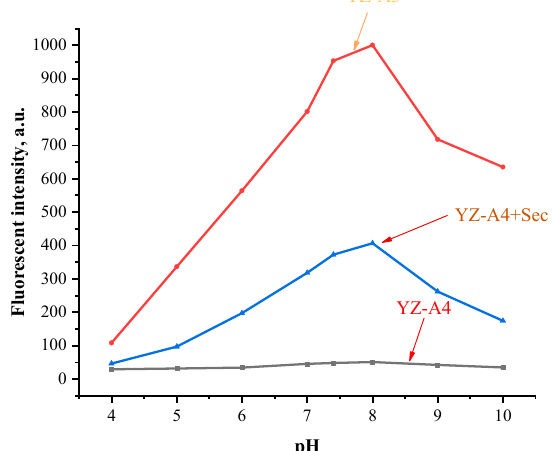
Figure 3. Fluorescent intensity of 10 μ M YZ-A3 (red), and YZ-A4 before (black) and after (blue) reaction with 10 μ M Sec in different PBS (pH 4–10, 10 mM, containing 1% DMSO as cosolvent). Excitation at 550 nm and emission at 614 nm.